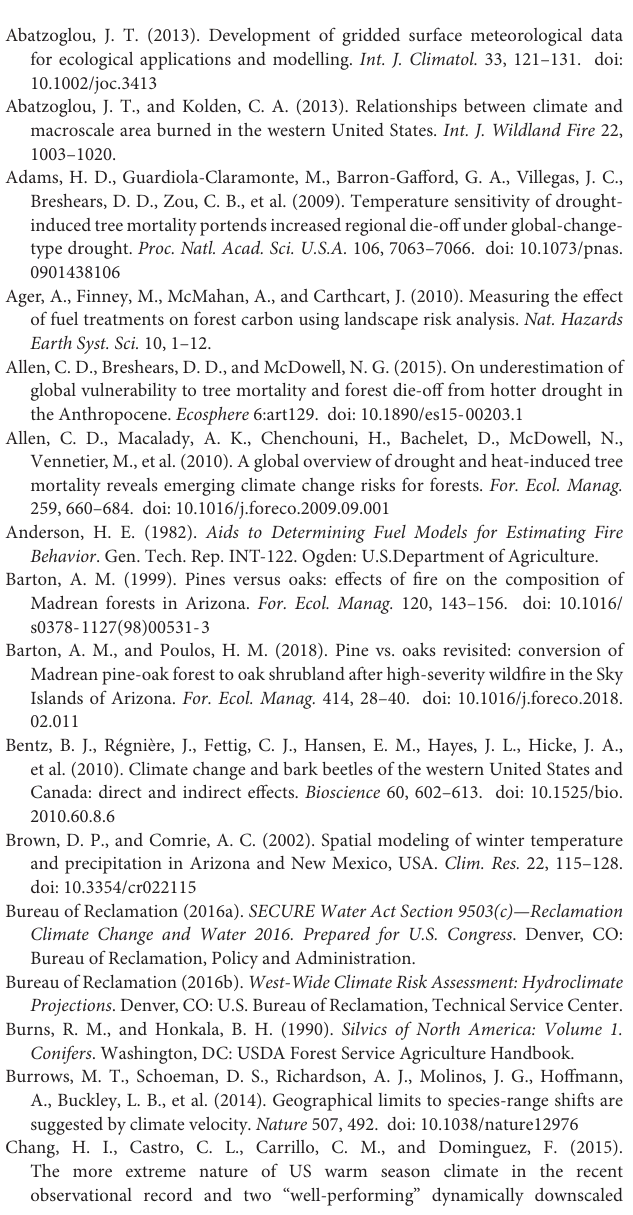
FIGURE S1 | Initial stand locations for model initiation under all scenarios. Color differences represent variability in vegetation type, height, and aspect.